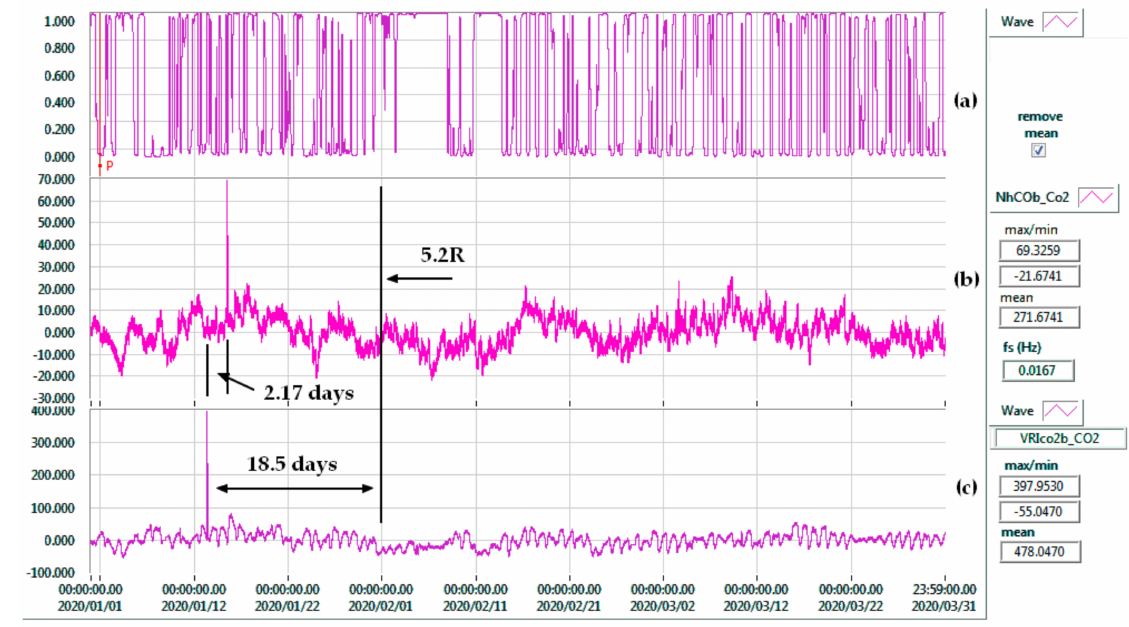
Figure 15. Comparative analysis of time series: ( a ) cross correlation (similar with Excel’s function CORREL) of CO 2 from Nehoiu ( b ) and CO 2 from Vrancioaia ( c